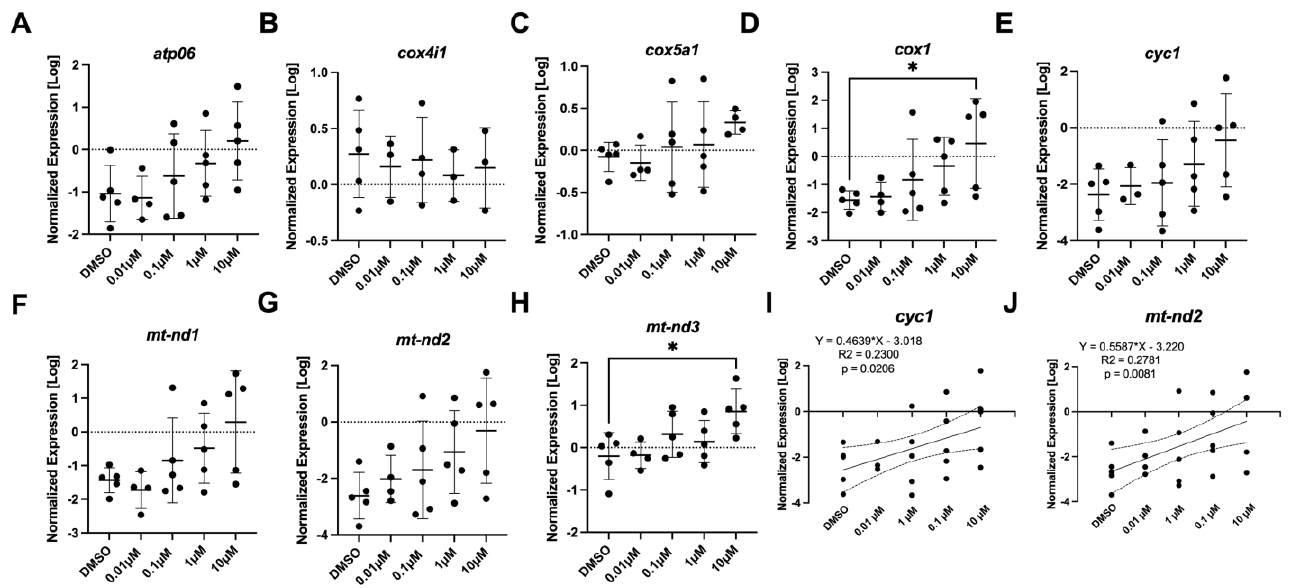
Figure 5. The expression levels of ( A ) atp06 , ( B ) cox4i1, ( C ) cox5a1, ( D ) cox1, ( E , I ) cyc1 , ( F ) mt-nd1, ( G , J ) mt-nd2, and ( H ) mt-nd3 in 7-day old larval zebrafish exposed to either 0.1% DMSO, 0.01 μM, 0.1 μM, 1 μM, or 10 μM PFTeDA. Each point is a biological replicate, and the horizontal line indicates the mean value of the group (mean ± S.D.) (one-way ANOVA with a Dunnett’s multiple comparisons test, n = 3–5/group). An asterisk denotes a significant difference at * p < 0.05 from the solvent control.